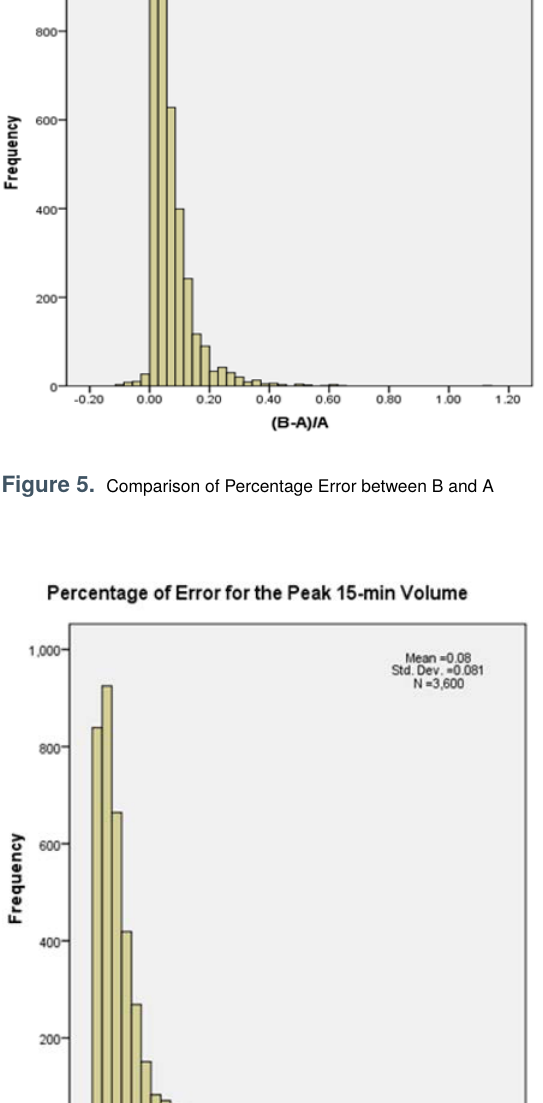
volume and lower PHF conditions, a 2% reduction in PHF